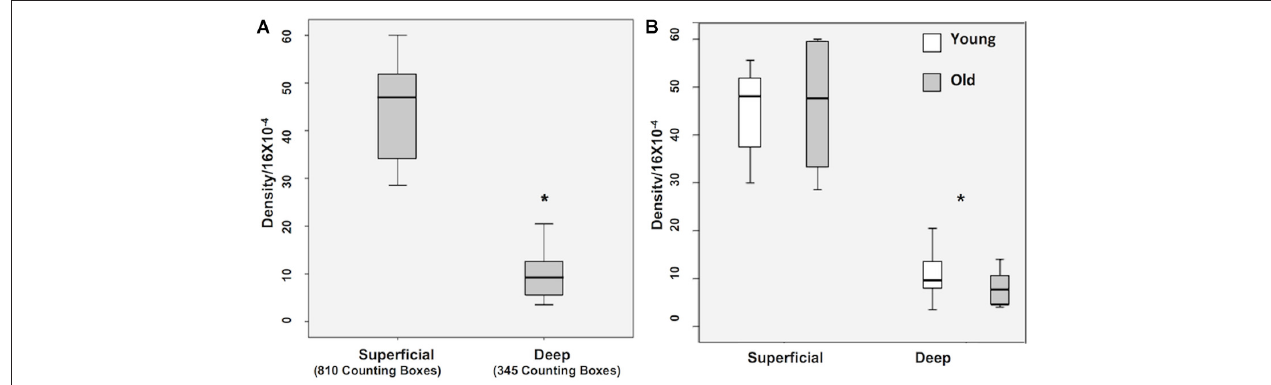
FIGURE 3 | Box plots of WMN density from Superficial and Deep zones in young (n = 4) and old (n = 4). (A) Box plot showing the non-normal distribution of white matter neurons (WMNs) in both strata. (B) Significant differences in the number of neurons between the strata, but not between the young and old monkeys. ∗ p < 0.05, compared to